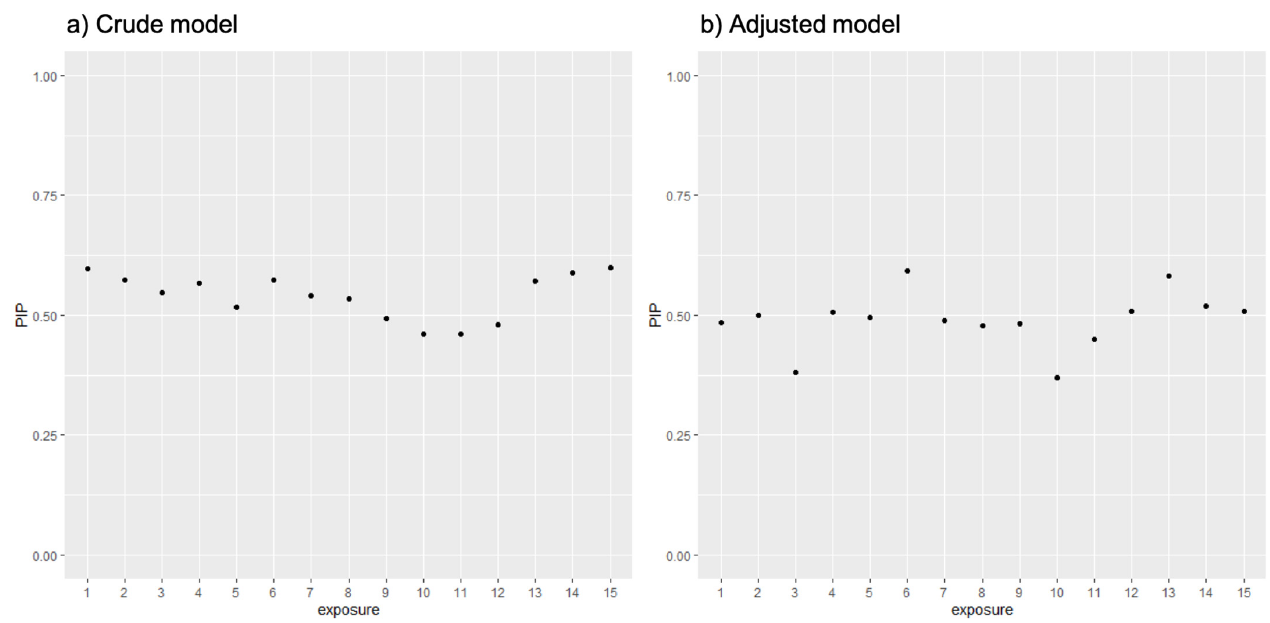
Figure A1. The plot of the spearman’s correlation matrix of 15 REEs. The concentrations of any two REEs in hair indicated significant correlations.